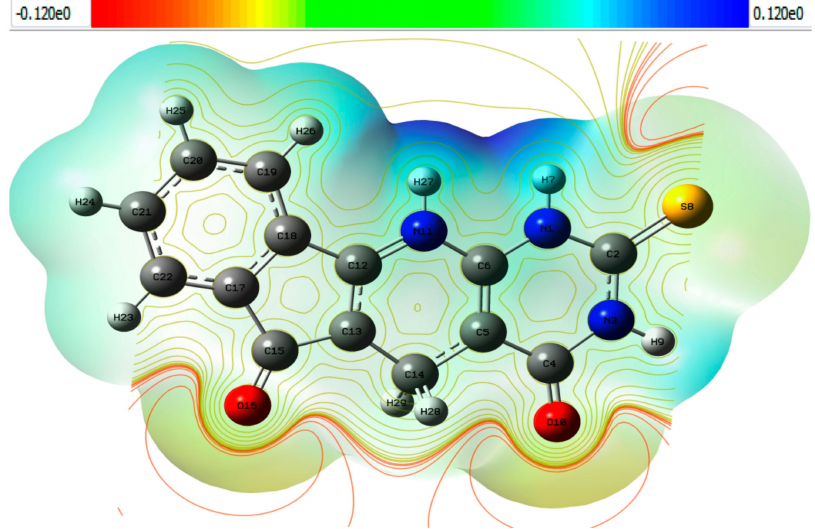
Figure 6. 2D and 3D Molecular electrostatic potential map of compound 1H of TUDHIPP